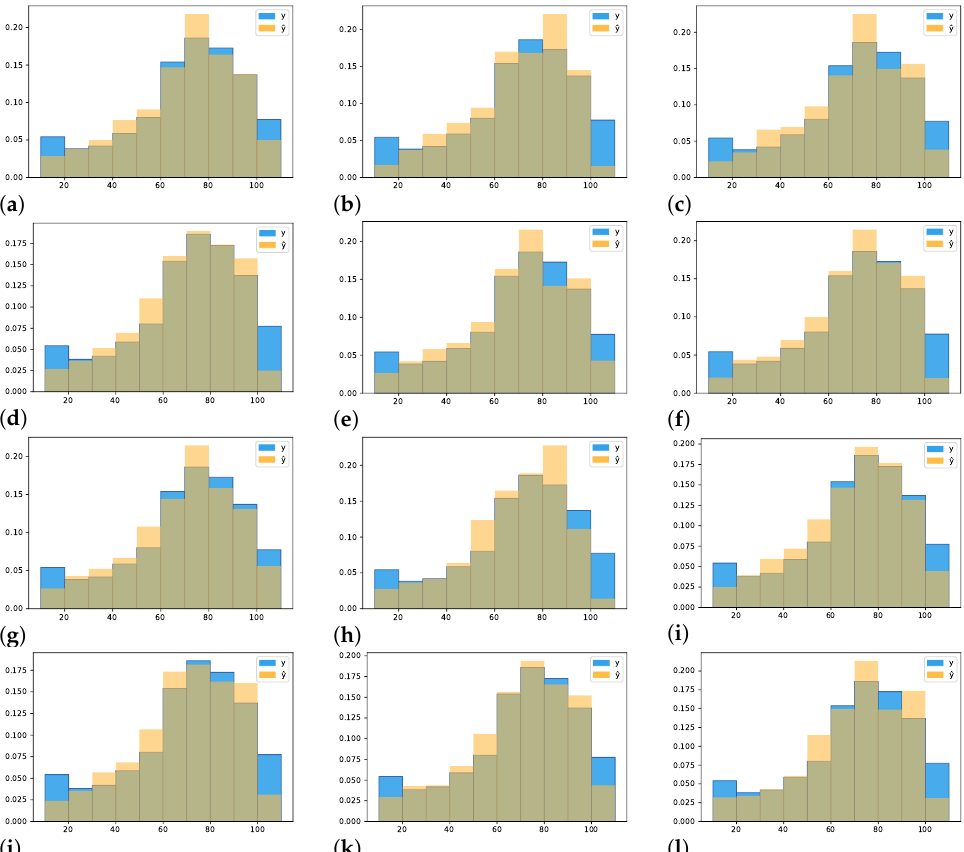
Figure 8. Comparison of prediction ˆ y vs. real y data discrete probability density distribution. ( a ) AlexNet pretrained. ( b ) AlexNet not pretrained. ( c ) ResNet18 pretrained. ( d ) ResNet18 not pre- trained. ( e ) ResNet34 pretrained. ( f ) ResNet34 not pretrained. ( g ) ResNet50 pretrained. ( h ) ResNet50 not pretrained. ( i ) ResNeXt101 pretrained. ( j ) ResNeXt101 not pretrained. ( k ) DarkNet pretrained. ( l ) DarkNet not